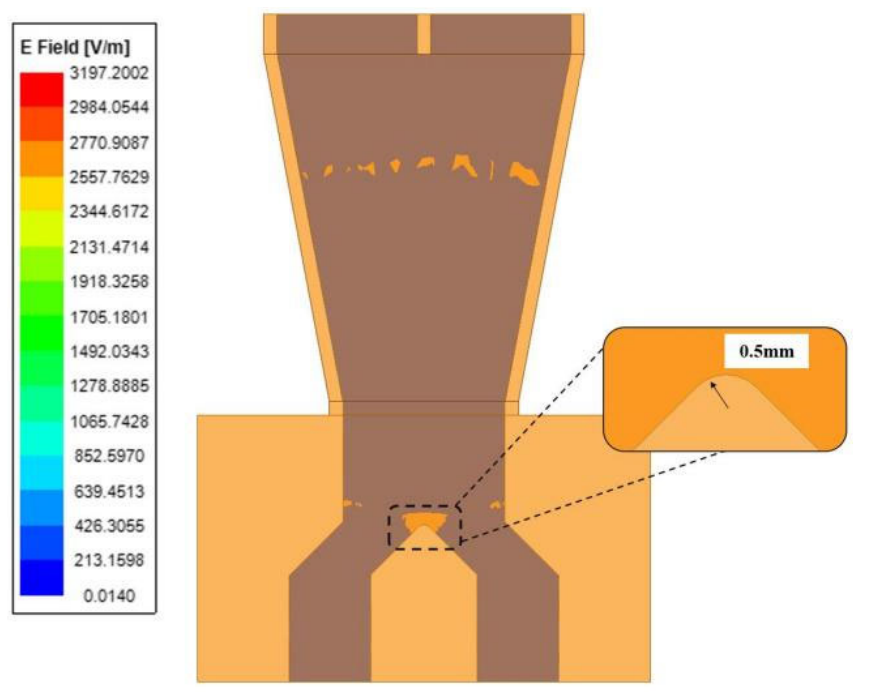
Figure 7. The field distribution of WG ‐ 1 and WG ‐ 3.